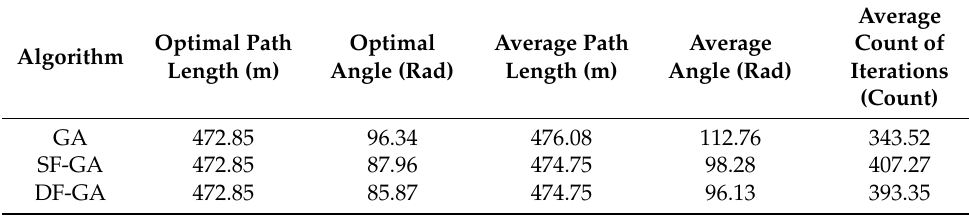
Table 2. Performance of different Genetic Algorithms in solving paths in study area A.